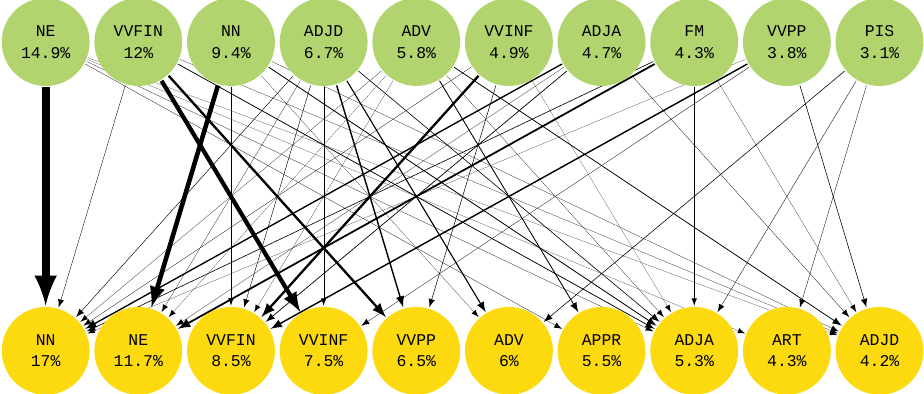
Figure 5: Depiction of the distribution and extent of erroneous POS tagging, com- paring gold-standard tags (top) with test-results (bottom), using STTS for all tag- gers on